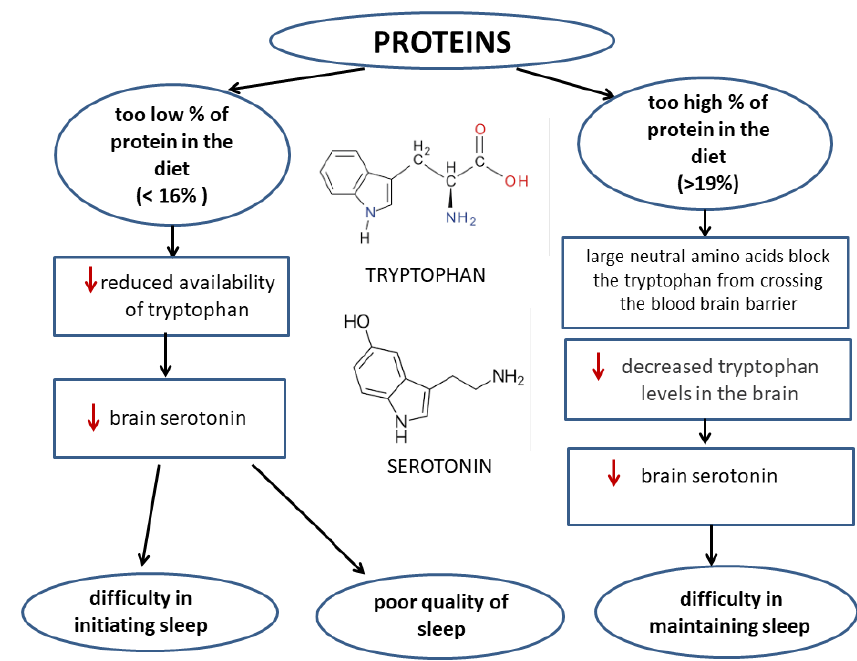
Figure 3. Protein intake and sleep quality.